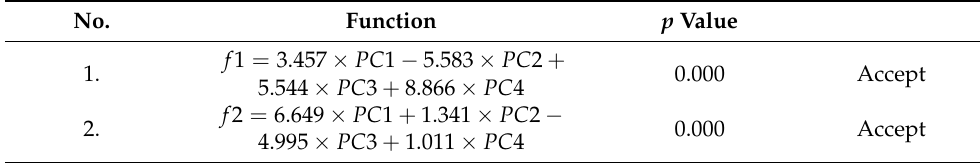
Table 3. Functions summarized from LDA and validation for 3DFS.